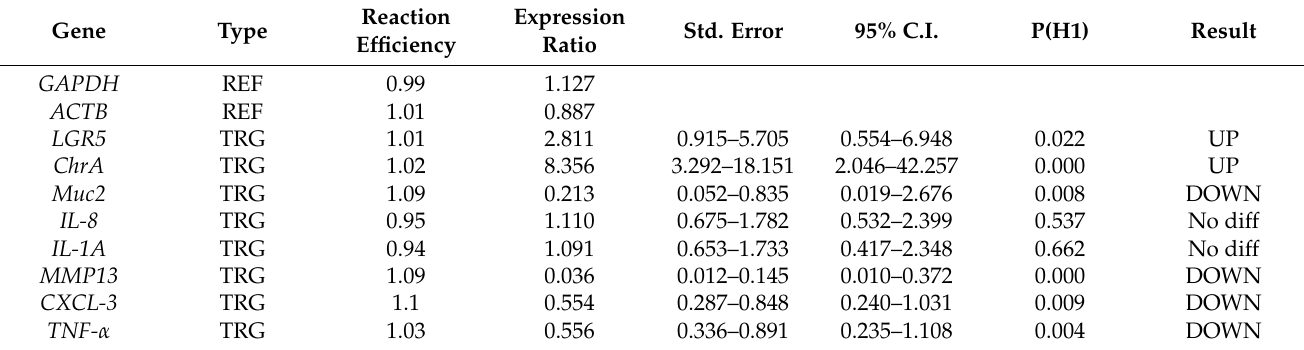
Table 3. Gene expression ratios for selected genes in BCoV- to mock-infected bovine enteroids. The enteroids were harvested 72 h post inoculation and mRNA was quantified by two-step RT-qPCR. The results were normalized to housekeeping genes GAPDH and ACTB. Three independent trials with mock- ( n = 9) and two with BCoV-infected ( n = 6) enteroids are